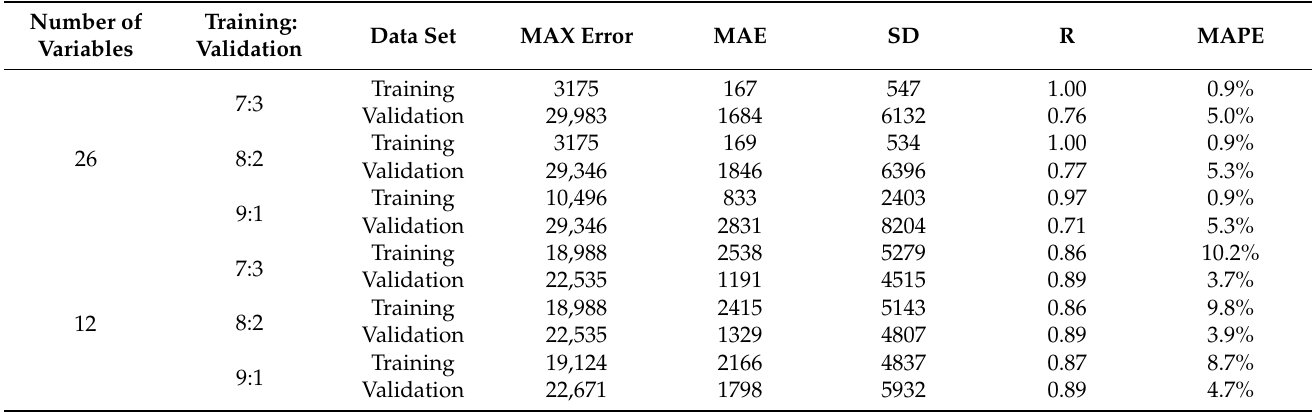
Table A7. Analysis of the results of the CHAID model for electricity